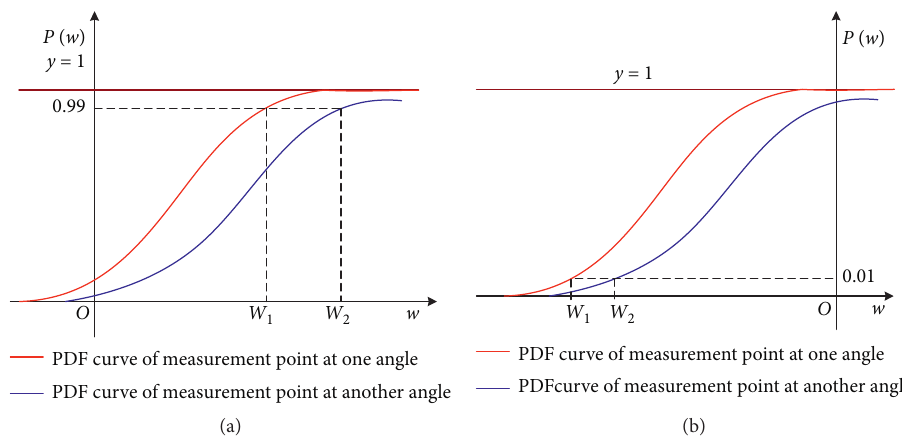
Figure 4: Diagram of probability distribution curve corresponding to guarantee rate. (a) Probability distribution curve with 99% assurance rate. (b) Probability distribution curve with 1% assurance rate.